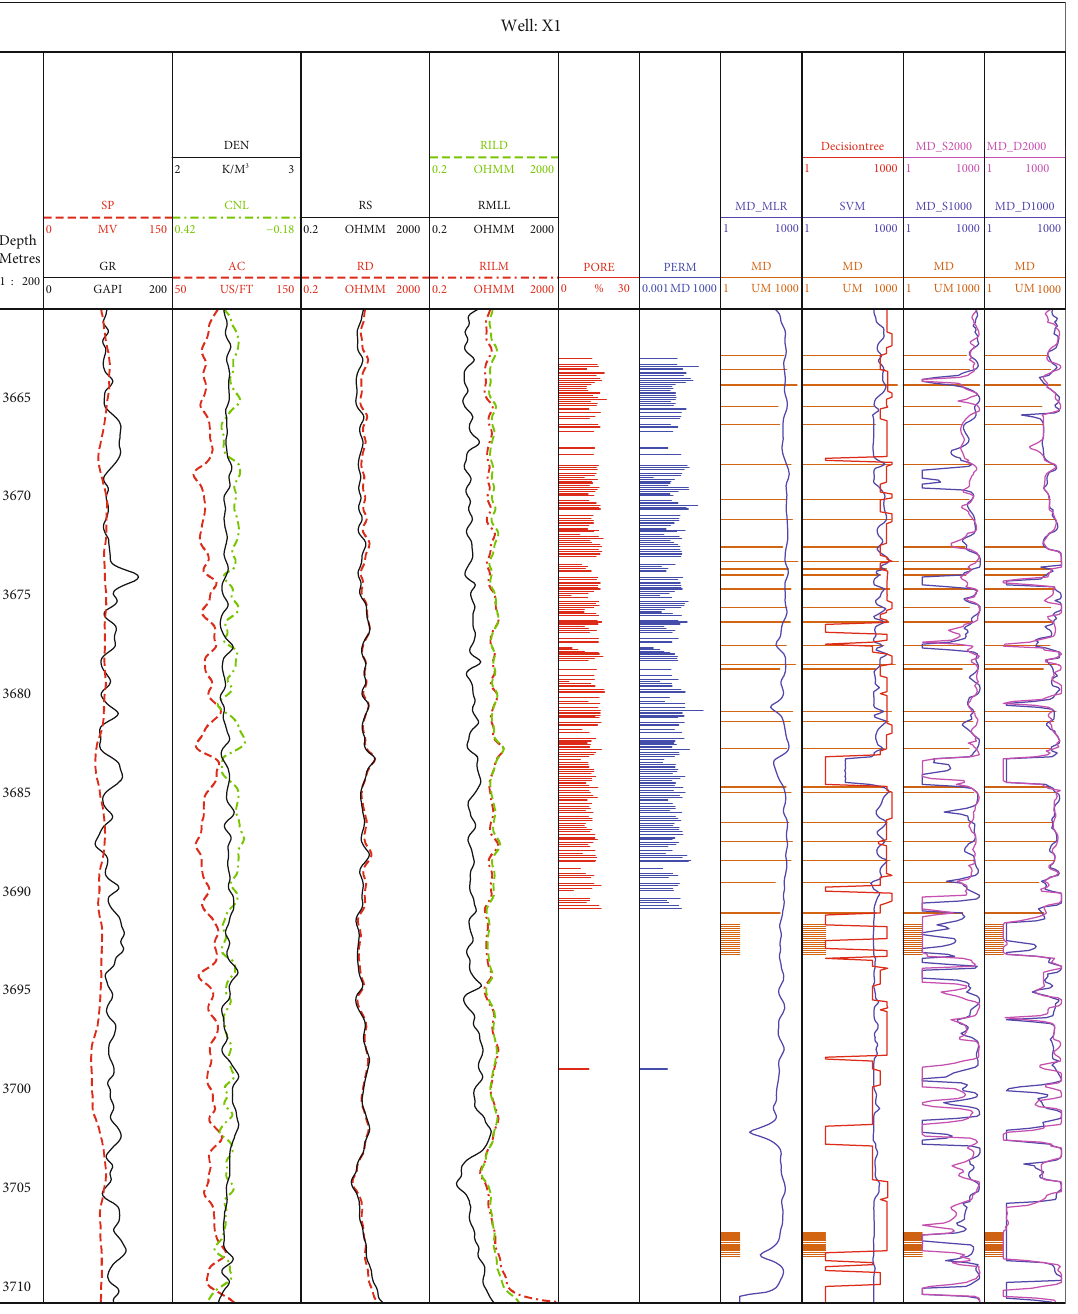
section of well 3